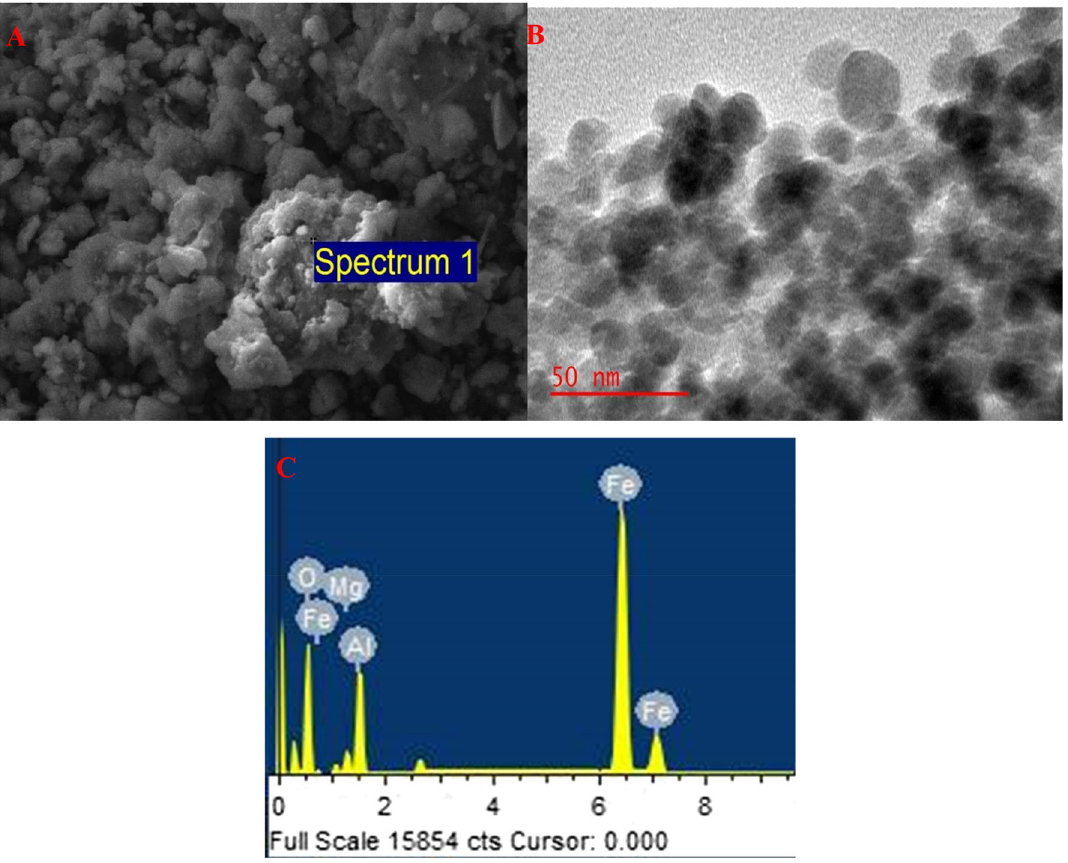
Figure 2. ( a ) SEM (10 µm) and ( b ) EDS and ( c ) TEM of Fe 3 O 4 @Al–Mg